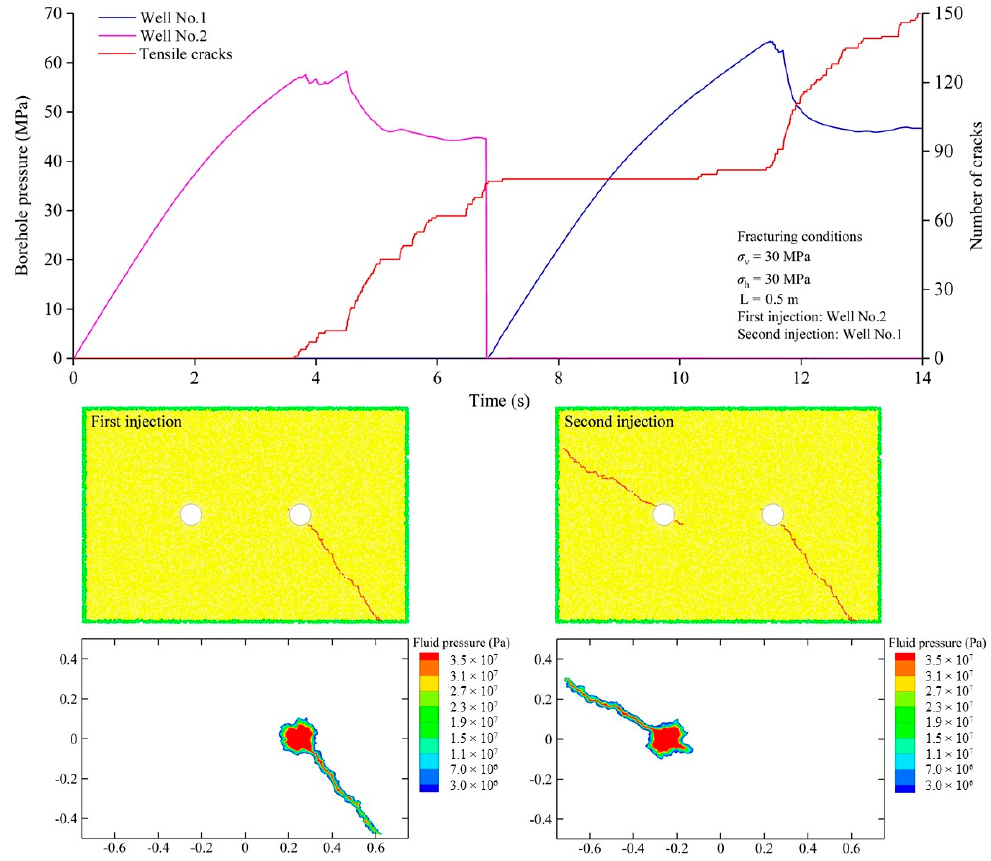
Figure 11. The borehole pressure histories, crack spatial distribution and corresponding fluid pressure field in the asynchronous fracturing (first injection: Well No.2 and second injection: Well No.1) under the hydrostatic pressure condition ( σ v = σ h = 30 MPa).